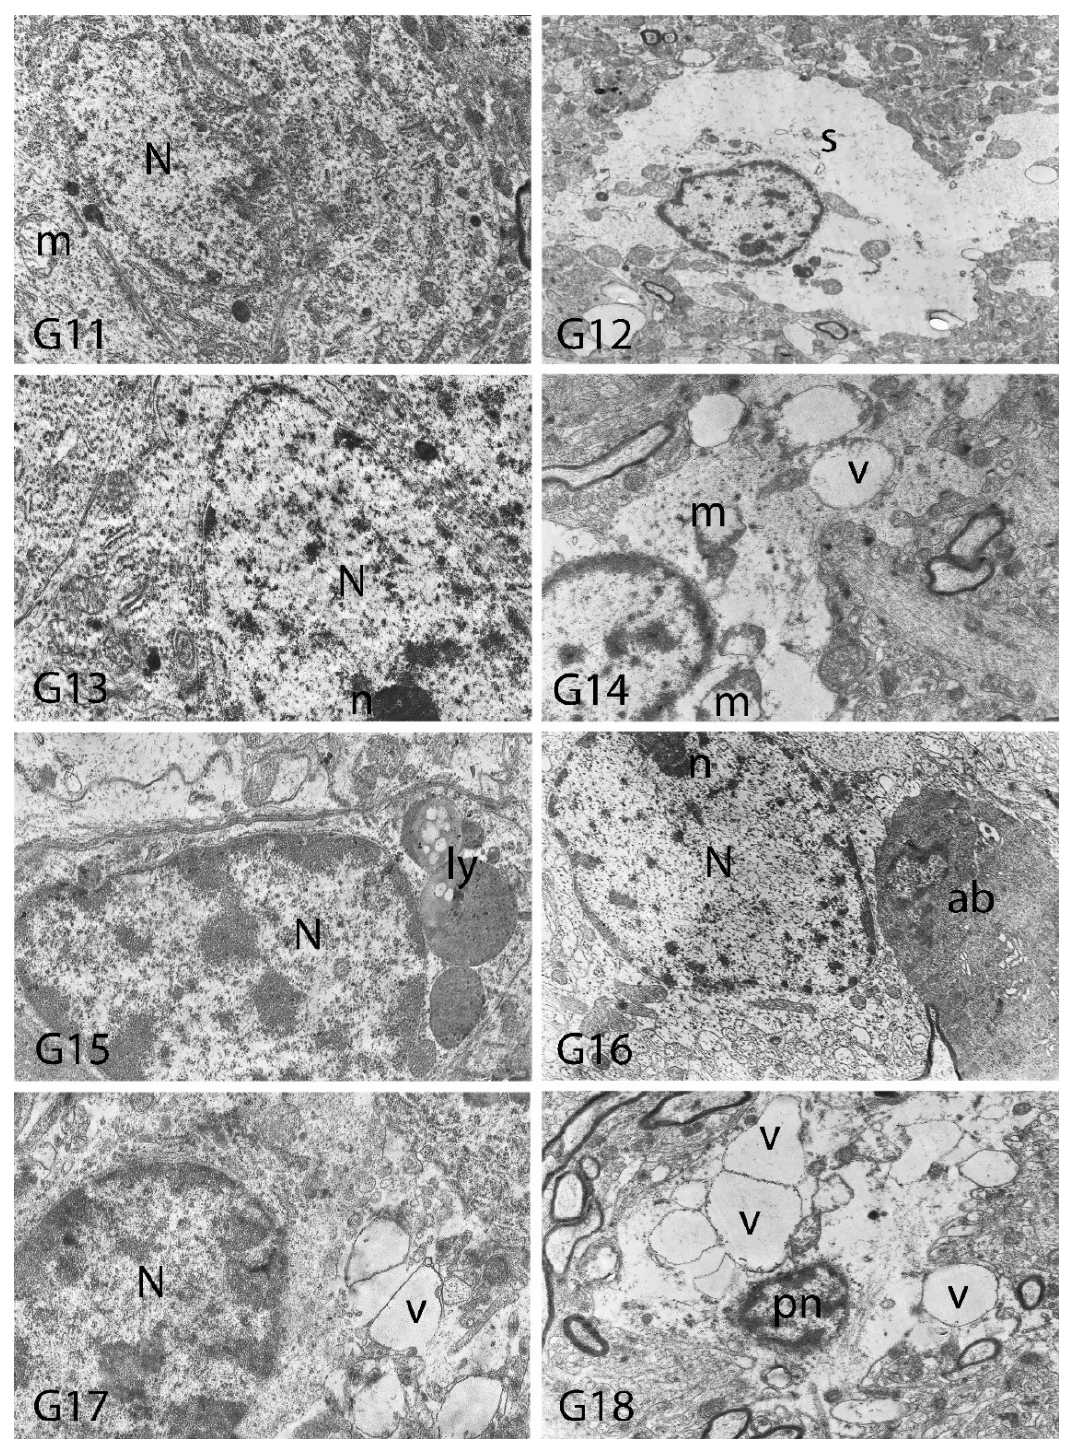
Figure 16. Electron micrographs of rat hippocampi from Groups 11 to 18 (G11–G18). N, nucleus; n, nucleolus; pn, pyknotic nucleus; m, damaged mitochondria; s, swollen cytoplasm; ly, secondary lysosomes; v, vacuolar degeneration; ab, apoptotic body. Group definitions are as in Figure 9. Table 7. Electron microscopic findings in cortex and hippocampus regions of rat brains after treat- ment with boron compounds and Al. (- nonsignificant; + significant at 10%; ++ significant at %5; +++ significant at %1; ++++sgnificant at %0.5; +++++ significant at %0.1) Mitochondrial Number of Secondary Vacuolar Degeneration Nuclear Pyknosis Damage Lysosomes Control - - - - Al (4.2 mg/kg)